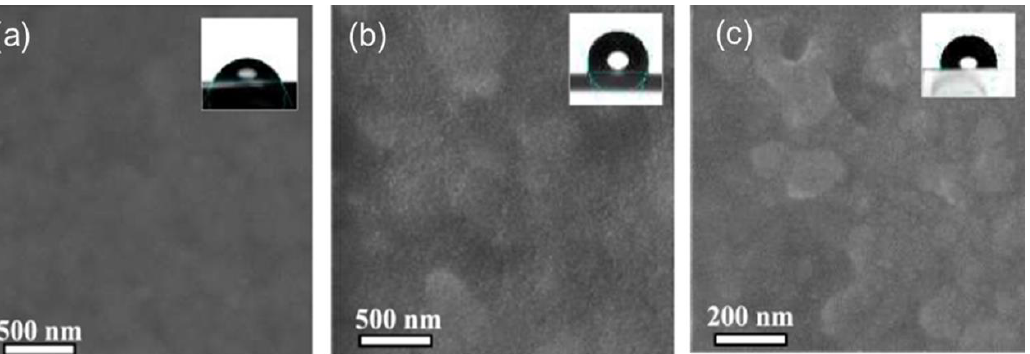
Figure 13. Top-view SEM image of various HTLs: ( a ) Spiro-OMeTAD, ( b ) wurtzite-CTS and ( c ) zincblende-CTS with water contact angles on the HTL surface shown inset. Reproduced from [138], with permission from the ACS Applied Energy Materials, 2021.